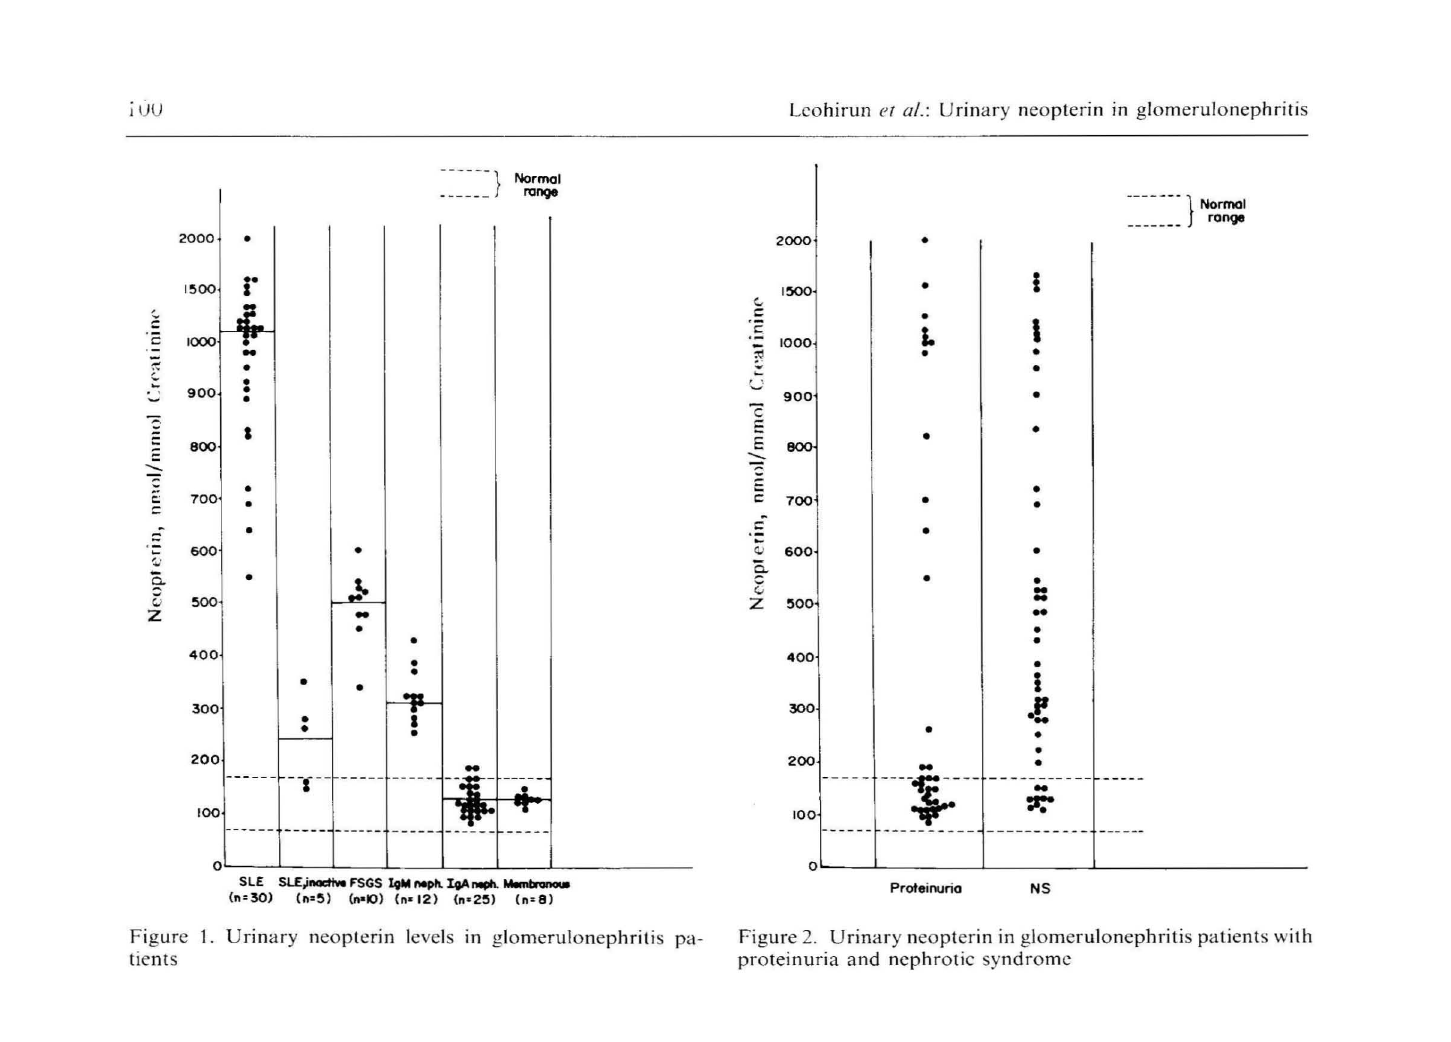
Figure 1. Urinary neopterin levels in glomerulonephritis pa tients